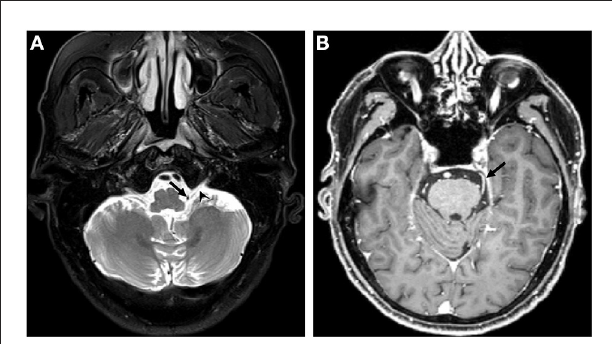
FIGURE1 MRI before the first operation. (A) The posterior inferior cerebellar artery (arrow) touches the left glossopharyngeal nerve (arrowhead); (B) The SCA (arrow) compression of the left trigeminal nerve is not displayed clearly. SCA, superior cerebellar